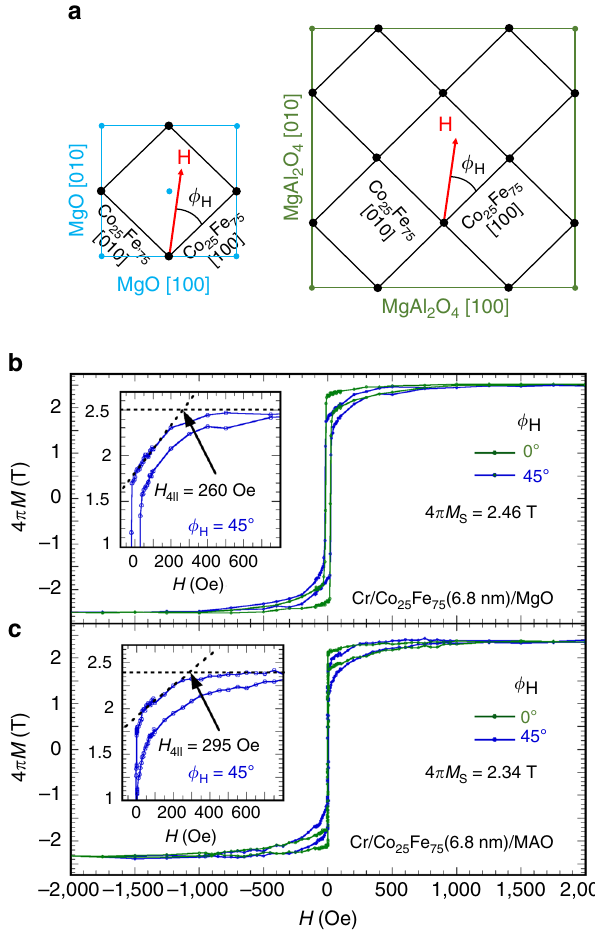
Fig. 3 Determination of in-plane magnetic hard axis. a Schematic illustration of the epitaxial relationship between the Co 25 Fe 75 lattice and the MgO and MAO(001) substrates as well as the in-plane fi eld angle ϕ H with respect to the Co 25 Fe 75 [100] axis. In-plane magnetic hysteresis loops for the b Cr(2.8 nm)/Co 25 Fe 75 (6.8 nm)/MgO(001) and c Cr(2.8 nm)/ Co 25 Fe 75 (6.8 nm)/MAO(001) sample for fi eld applied along a Co 25 Fe 75 [100] axis ( ϕ H = 0°, easy axis) and a Co 25 Fe 75 [110] axis ( ϕ H = 45°, hard axis). A saturation magnetization of 2.46 and 2.34 T as well as an easy-axis coercive fi eld of 20 and 2.5 Oe are obtained for the 6.8 nm Co 25 Fe 75 fi lm on MgO and MAO, respectively. The insets in b and c show a zoom-in view of the hard-axes hysteresis loops ( ϕ H = 45°) to extract the in-plane magnetocrystalline anisotropy, H 4 || = 260 and 295 Oe, for the Co 25 Fe 75 fi lm on MgO and MAO,